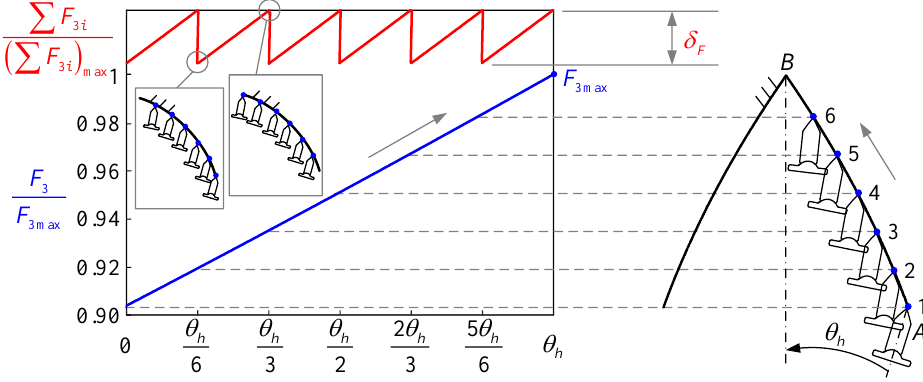
Figure 13. Variation in total contact force versus the rotation angle.